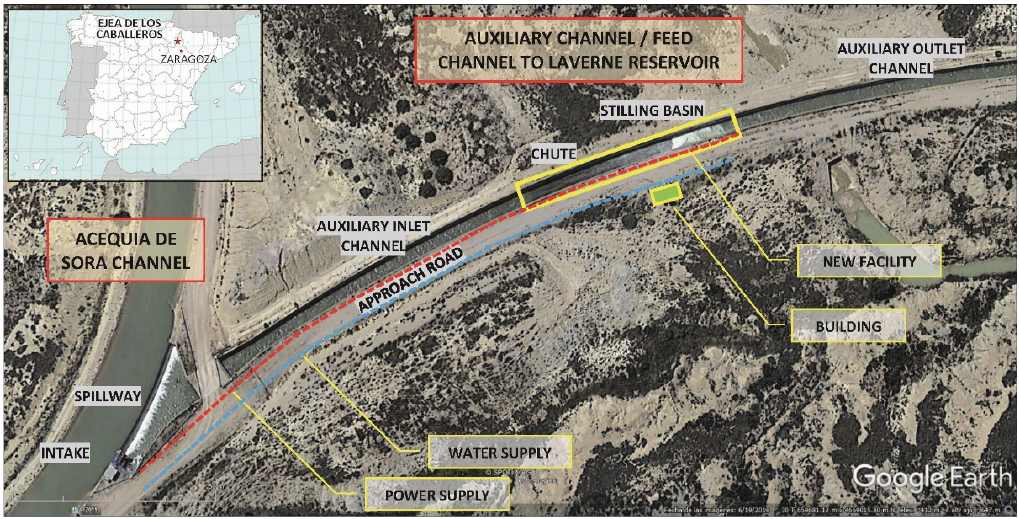
Figure 1. Location of test facilities (geographic coordinates 42°3 ′ 59.34 ″ N, 1°4 ′ 12.22 ″ W).